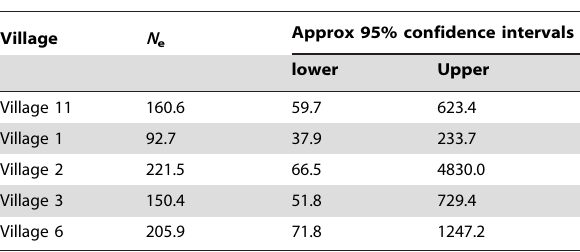
Table 3. Estimates of effective population size ( N e ) of Aedes (Stegomyia) aegypti (L.) in five villages in Thailand based on Waples’ [20] method using temporal differences in allele frequency across 9